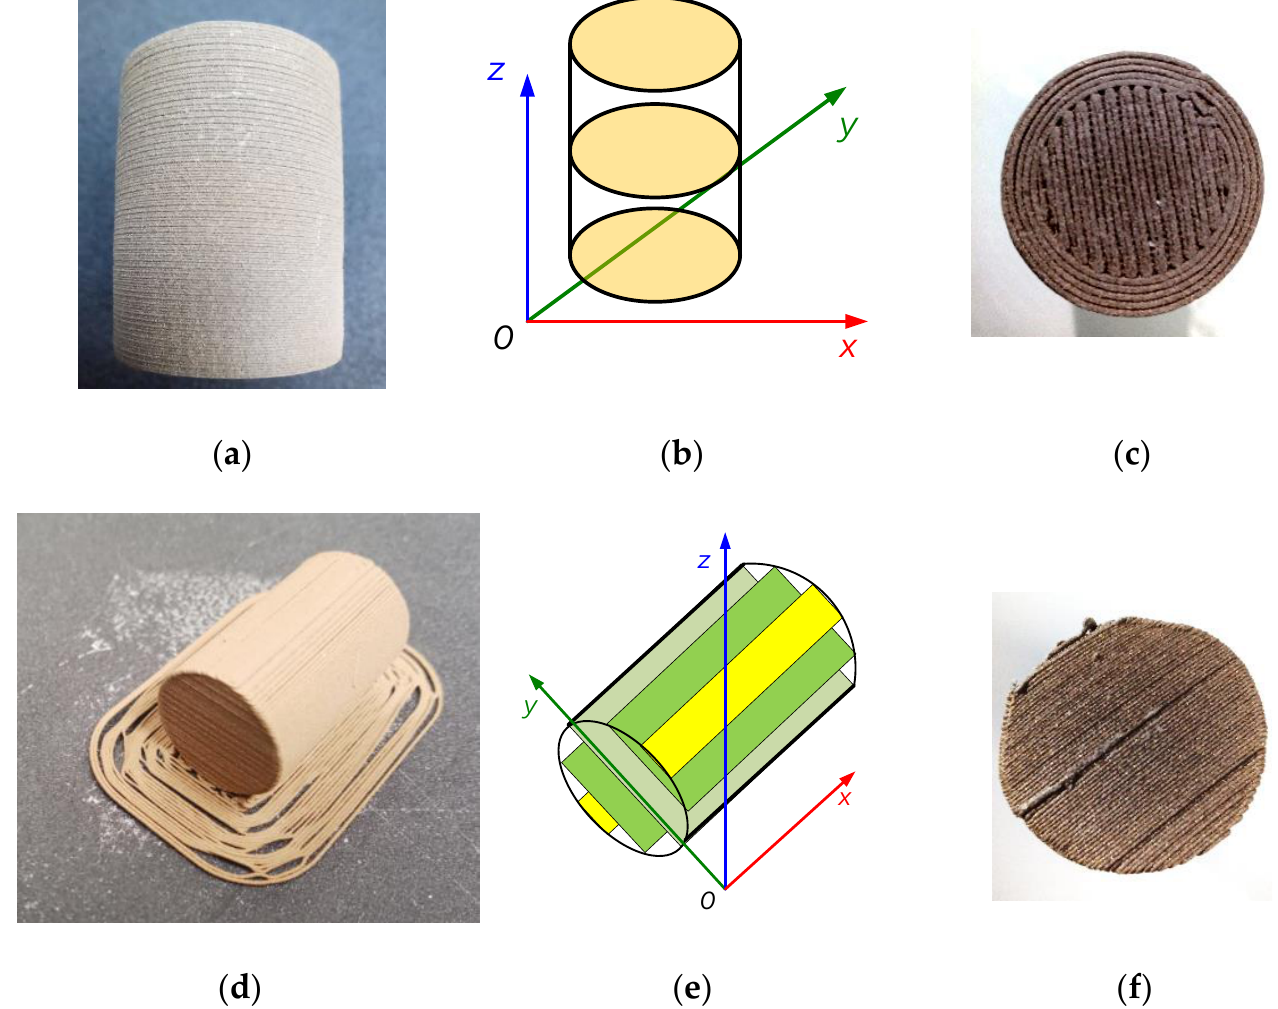
Figure 3. PLA bronze-filled samples: ( a ) vertically layered printed sample; ( b ) schematic of vertically layered printed sample; ( c ) top view of the vertically layered printed sample; ( d ) horizontally layered printed sample; ( e ) schematic of horizontally layered printed sample, ( f ) top view of the horizontally layered printed sample.